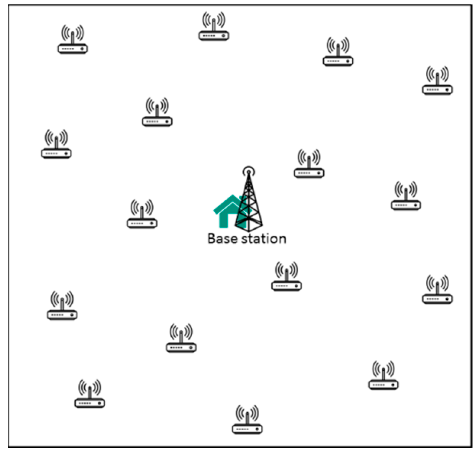
Figure 3. Example of WRSNs. Table 3. The definition of related parameters.